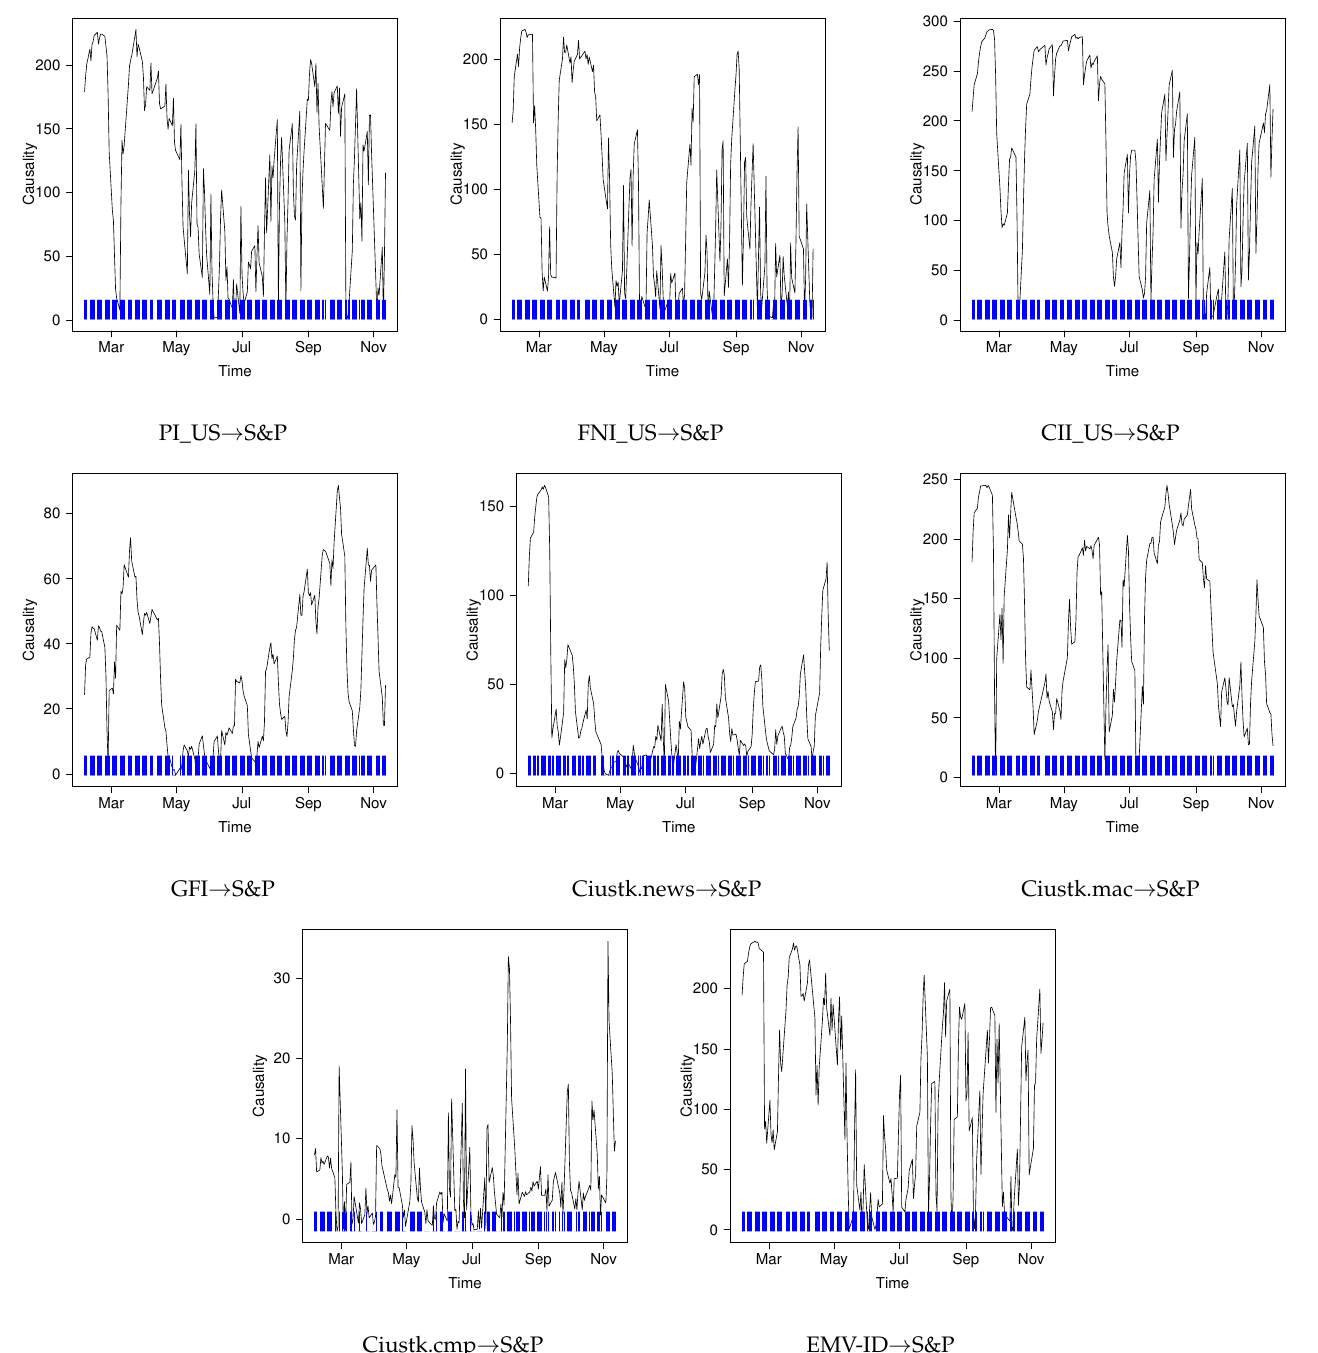
Figure 7. Instantaneous, one-way Granger-causality from news series to S&P (DCC-GARCH